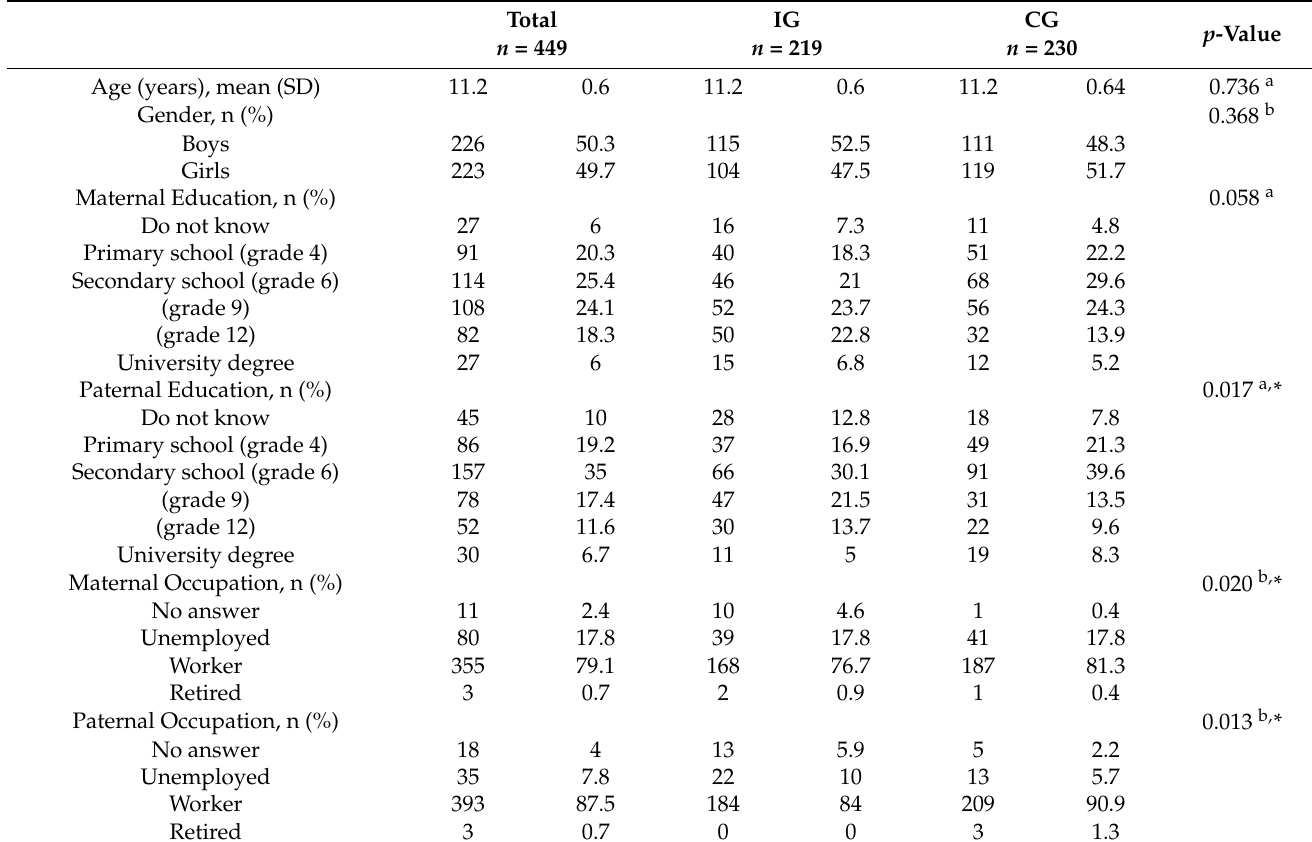
Table 1. Demographical and socio-economical characteristics of intervention group (IG) and control group